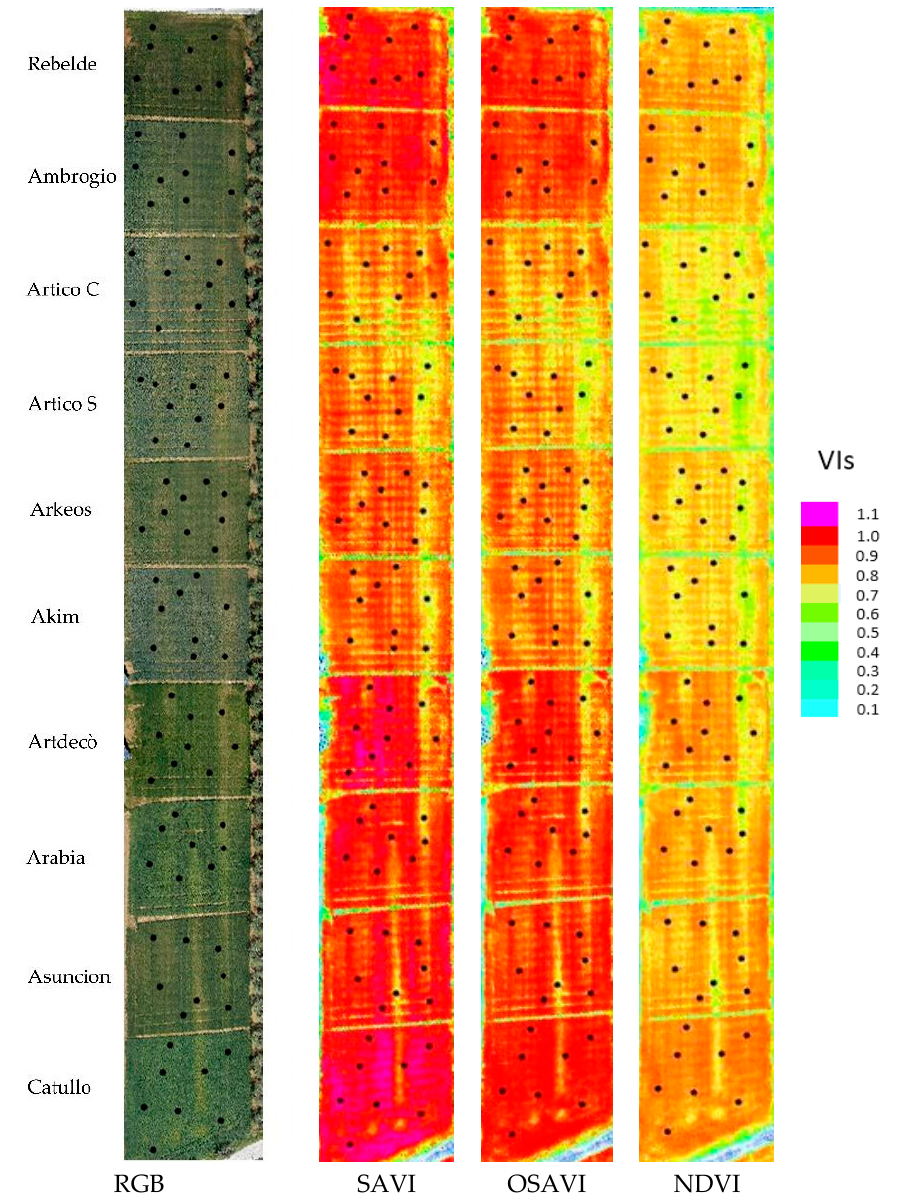
Figure 1. RGB (visible) map and Soil Adjusted Vegetation Index (SAVI), Optimized Soil Adjusted Vegetation Index (OSAVI), and Normalized Difference Vegetation Index (NDVI) maps of the ten cultivars with the agronomic sampling points.